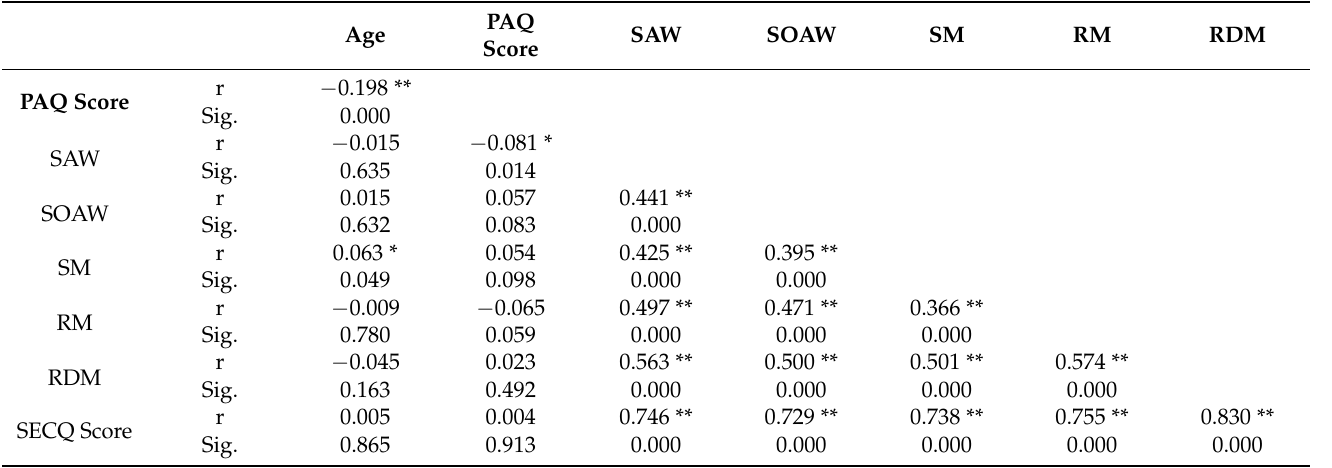
Table 6. Correlations between the different factors and the independent